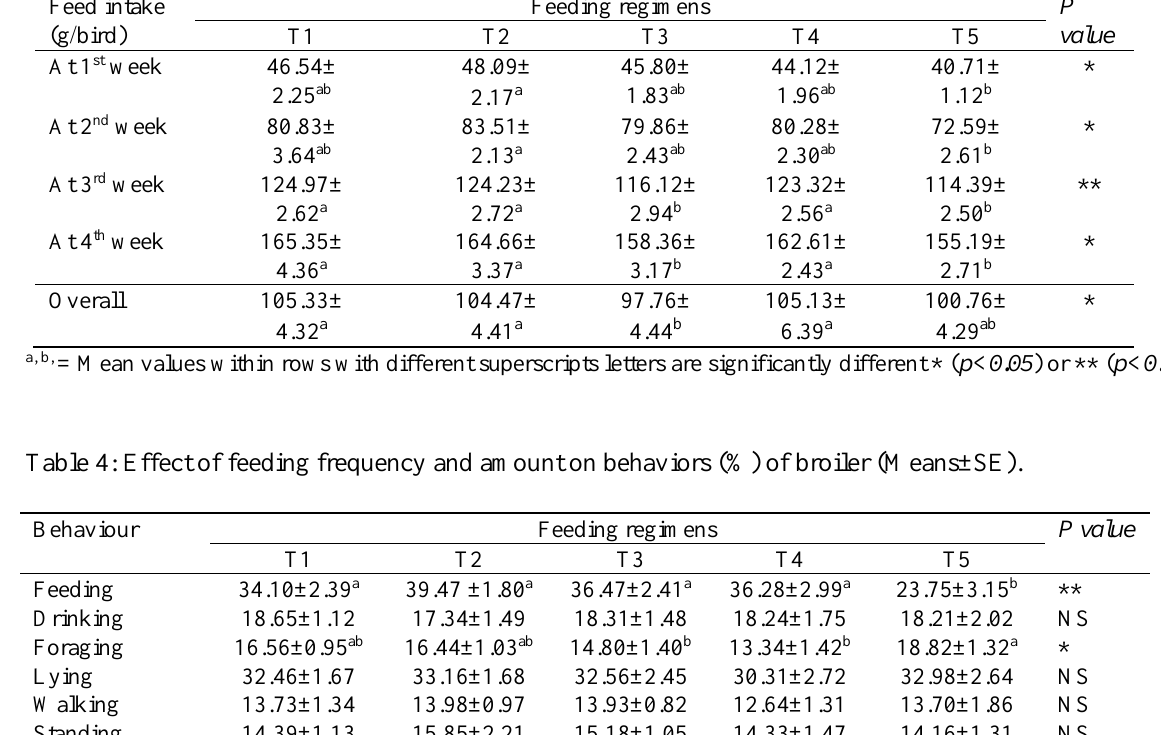
Table 3: Effect of feeding frequency and amount on feed intake (g/bird) of broiler (Means±SE). Feed intake (g/bird)